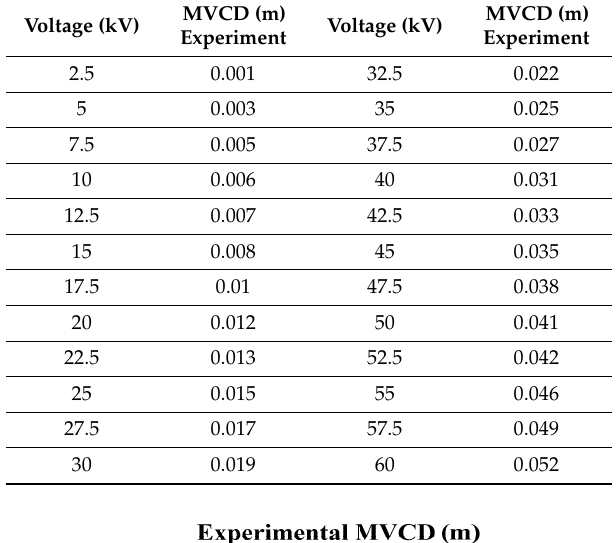
Table 3. Experimental values of MVCD at different voltages.